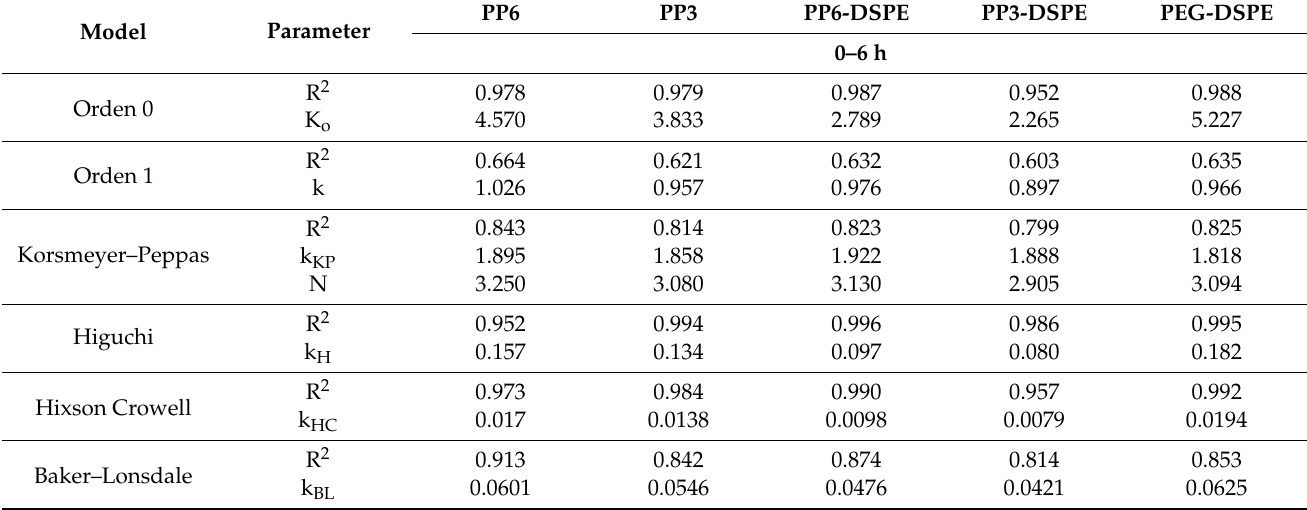
Table 3. Kinetic analysis of the release